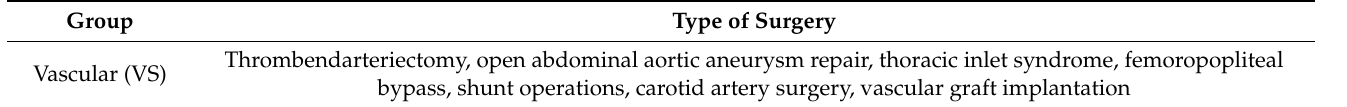
Table 2. Overview of the individual operations of the different